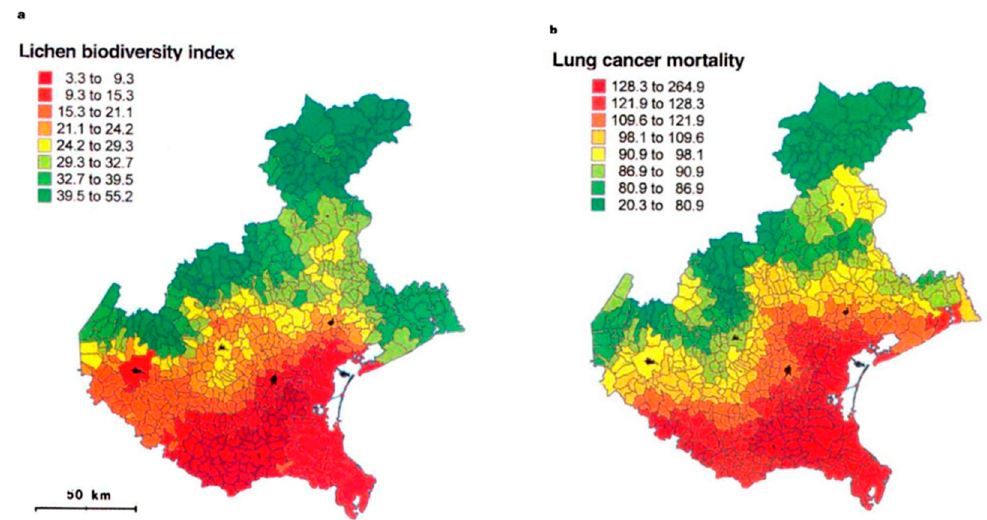
Figure 1. ( a ) Lichen biodiversity index, calculated as the sum of frequencies of all epiphytic species in a sampling grid of 10 units; ( b ) lung cancer mortality in young male residents (expressed as observed / expected cases × 100), in the Italian region of Veneto. Scale intervals are based on percentiles of values distribution. Reprinted by permission from Springer Nature: Cislaghi and Nimis, “Lichens, air pollution and lung cancer”. © Nature, 387:463–464, 1997.